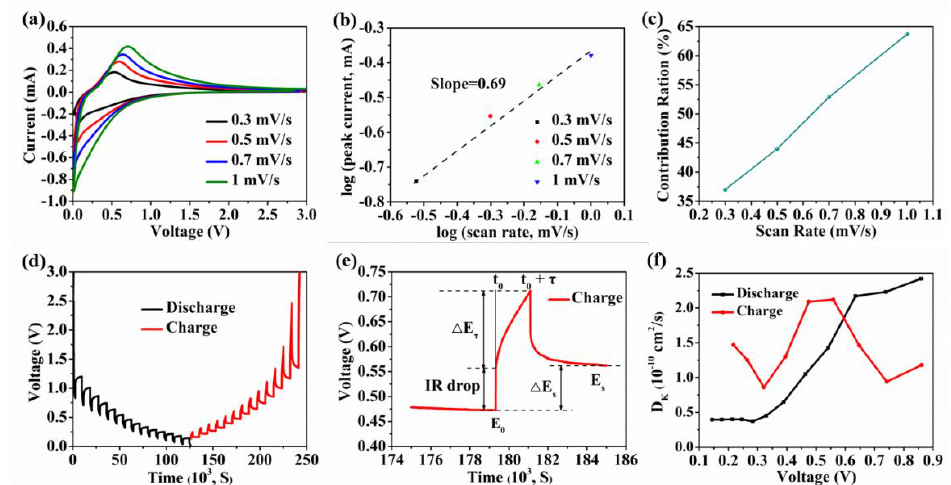
Figure 3. ( a ) CV curves at various scan rates. ( b ) Relationship between the peak current and scanning rates. ( c ) Capacitance contribution at different scan rates. ( d ) GITT curve. ( e ) A single GITT titration curve. ( f ) K − ion apparent diffusion coefficients for the discharge and charge